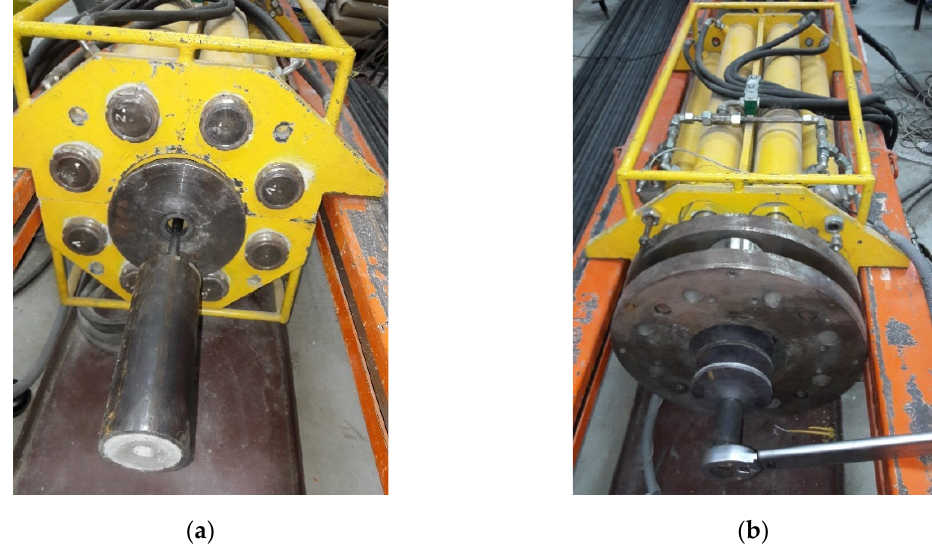
Figure 11. Installation of the rock bolt support on the laboratory station: ( a ) arrangement of bolt rod with a mechanical head into rock core (without extending the cylinders); ( b ) pre-tension (at full spread of the bolt).